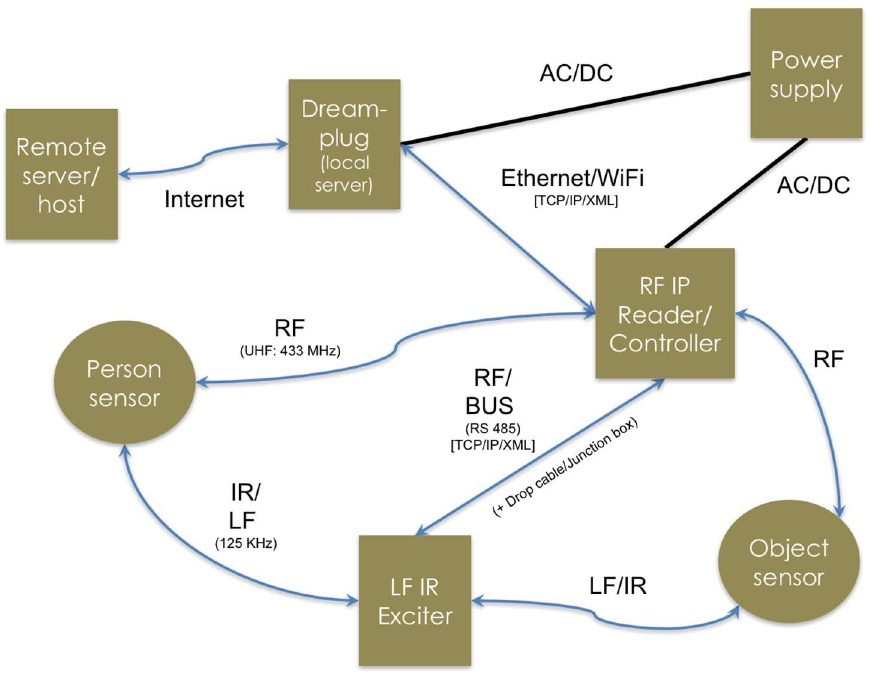
Fig 1. Elpas researchsystem.